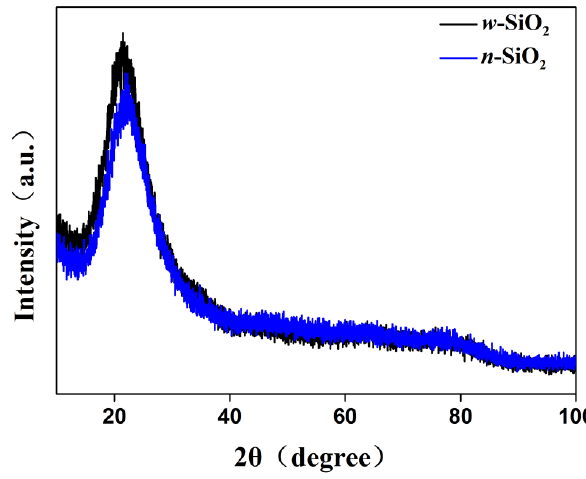
Figure 7. XRD patterns of n -SiO 2 and w -SiO 2 samples.